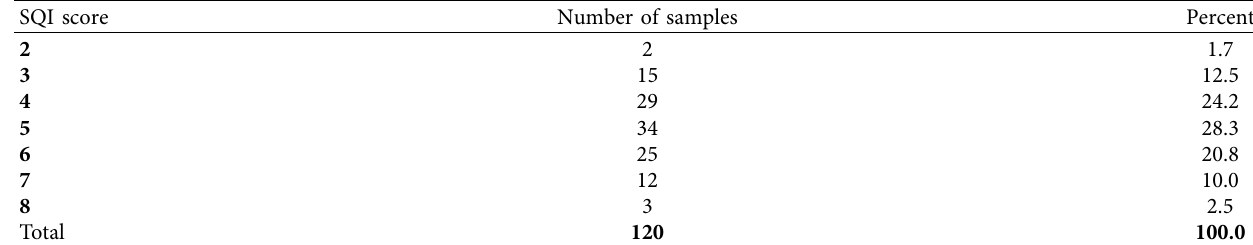
Table 5: Soil quality index of soil samples.